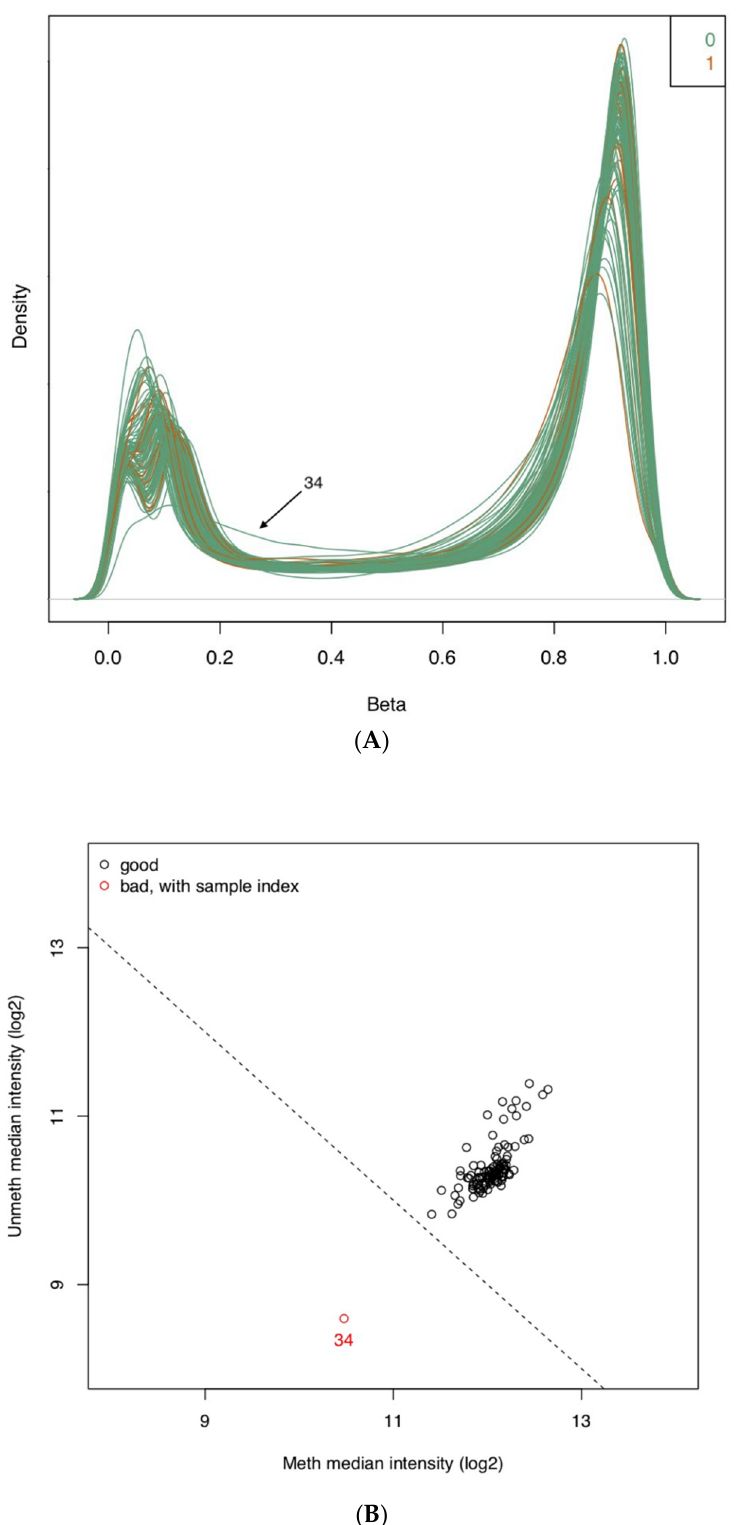
Figure 1. ( A ): β -value density plot for quality control purposes. Each line represents the density distribution of methylation levels for each CpG site throughout the genome. The number 0 and associated green lines represent samples from subjects not reporting suicidal ideation, whereas the number 1 and corresponding red lines represent samples from subjects reporting current suicidal ideation. The two peaks in the distribution curve are seen near 0.0 and 1.0 and refer to the